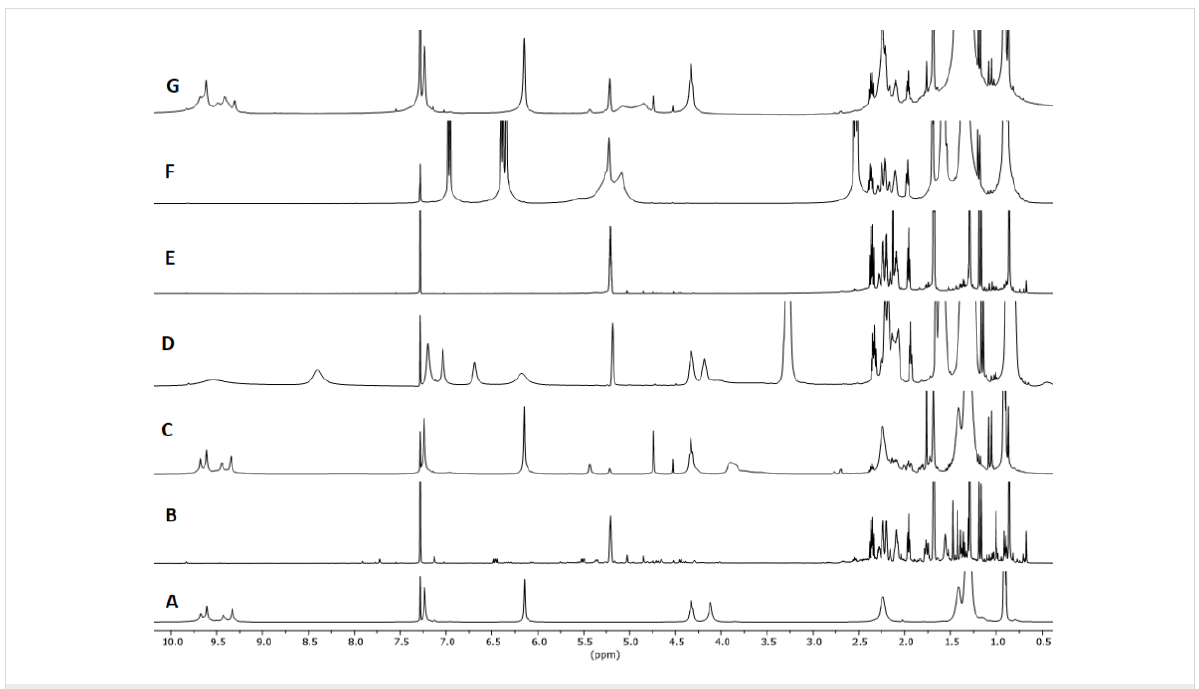
Figure 3: 1 H NMR spectra in water-saturated CDCl 3 except for G. A: [ 1 6 ] (7.5 mM); B: α -pinene; C: α -pinene (75 mM), [ 1 6 ] (7.5 mM); D: α -pinene (75 mM), [ 1 6 ] (7.5 mM), Bu 4 NBr ( 3 , 78 mM); E: α -pinene (75 mM), acetic acid (29 mM); F: α -pinene (75 mM), n -hexylresorcinol ( 2 , 30 mM);